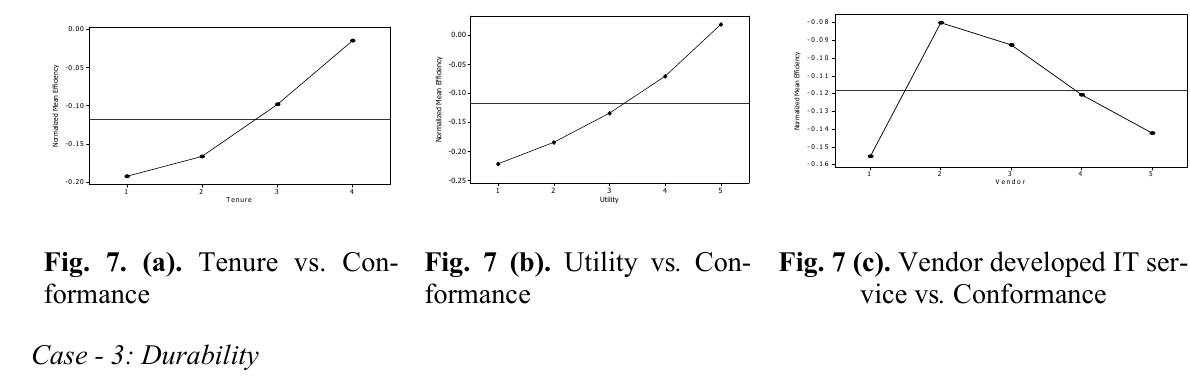
Fig. 7 (b). Utility vs . Con- formance